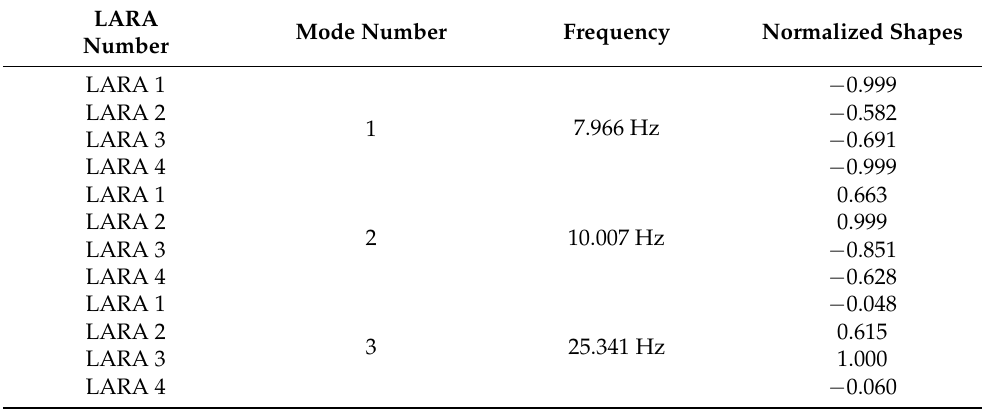
Table 8. Modal analysis output of the SSI-cov application for the four low-cost sensors.